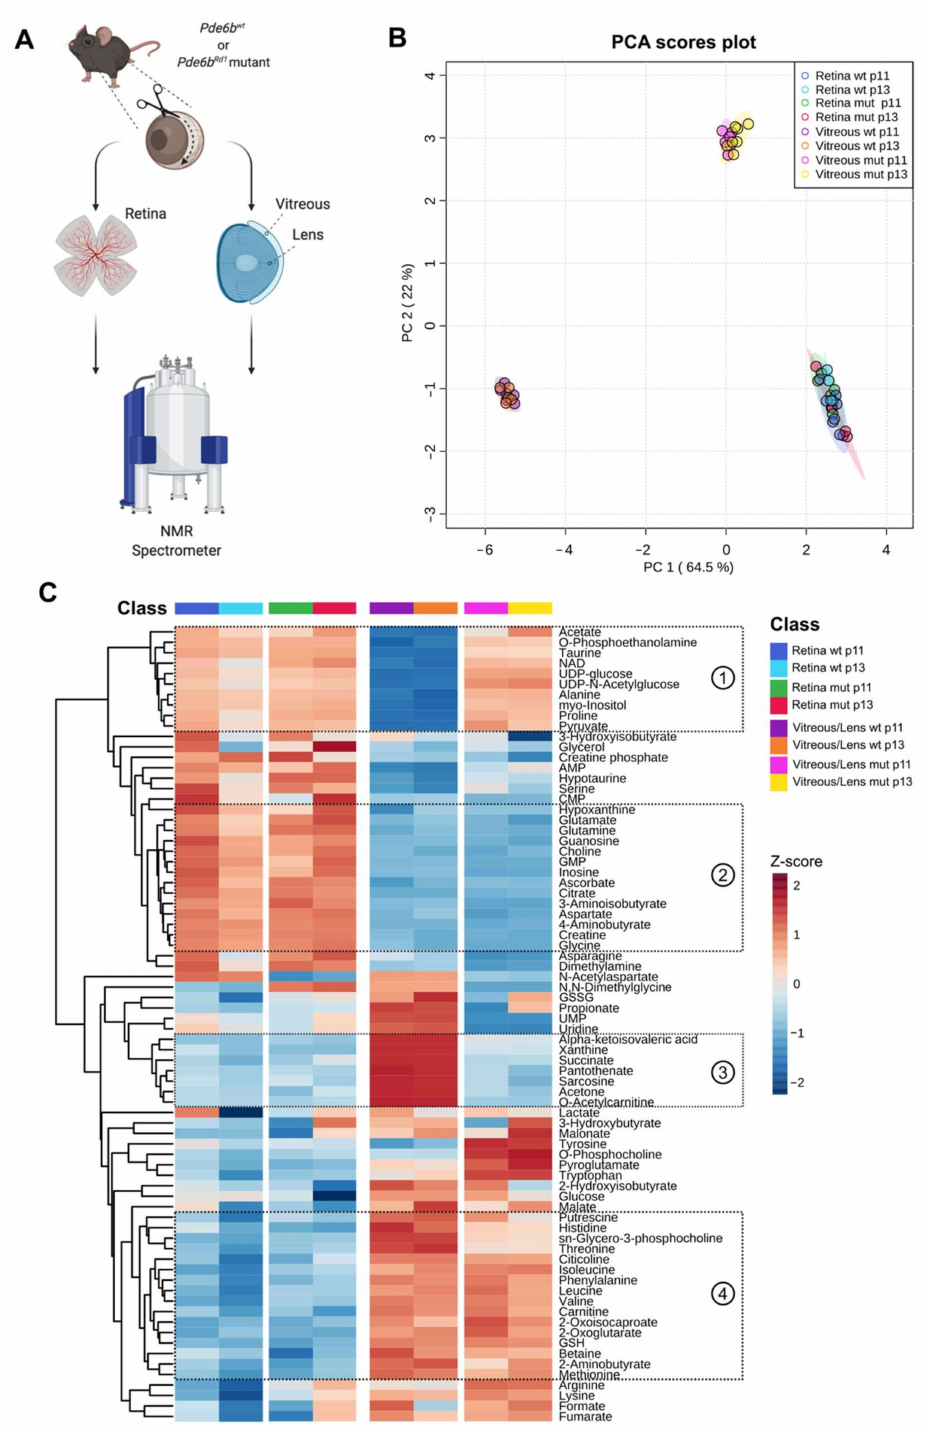
Figure 2. A comprehensive metabolomic analysis reveals time-, compartment-, and degeneration state-dependent differences. ( A ) Schematic overview of the experimental workflow. ( B ) Principal component analysis of all collected metabolomic data, reflecting differences regarding the time-point of analysis (p11, p13), the compartment (retina and vitreous/lens), and the phenotype (wt, Rd1 mutant). ( C ) A heatmap representing the z-score of absolute concentration levels of 76 metabolites across all conditions, clustered according to the Euclidean distance. The circled numbers (1 to 4) indicate the clusters discussed in the main text. Rd1 wt, vitreous/lens: n = 6 (p11), n = 5 (p13); retina: n = 7 (p11), n = 4 (p13). Rd1 mutant, vitreous/lens: n = 6 (p11), n = 7 (p13); retina: n = 5 (p11), n = 6